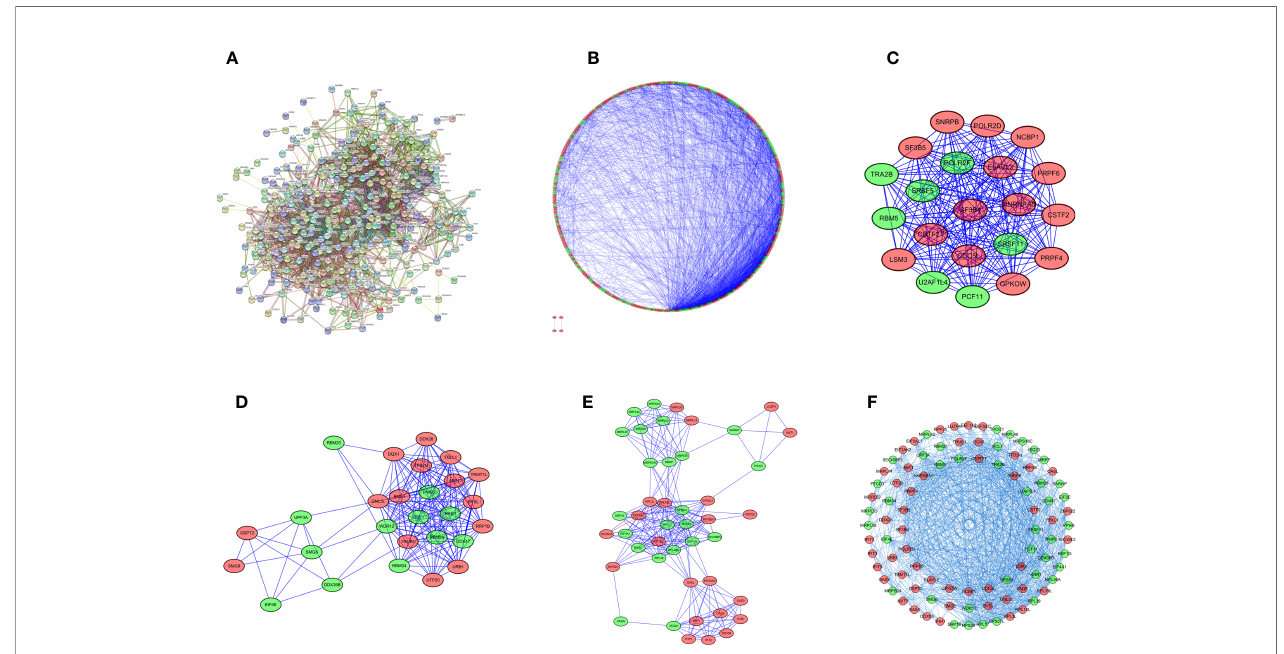
FIGURE 3 | Protein-protein interaction network and module visualization. (A) Initial protein-protein interaction analysis of 329 differentially expressed RBPs. (B) the visualization of Protein-protein interaction network of 329 differentially expressed RBPs. Critical module 1 (C) , 2 (D) , and 3 (E) from PPI network using MCODE in Cytoscape. Module 1 contains 21 points and 209 edges, Module 2 contains 27 points and 190 edges, and module 3 contains 44 points and 236 edges. (F) Visualization of the integration of module 1,2 and 3. Green circles represent down-regulated RBPs, red circles represent up-regulated